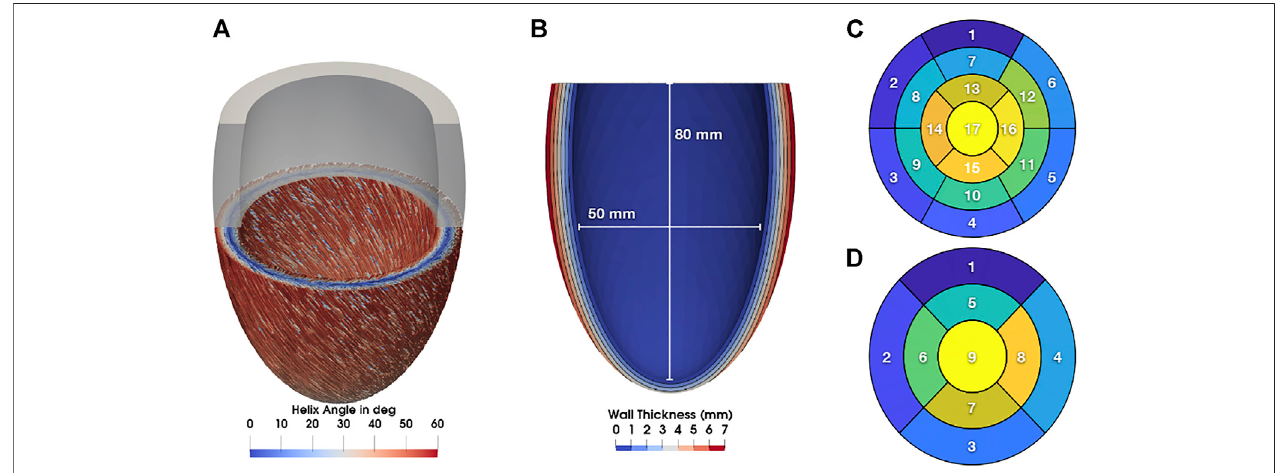
FIGURE 1 | (A) Myocyte orientation in the LV colorized with the corresponding helix angle. (B) Long axis cut through the LV with contours showing the wall thickness. Additionally, lengths for the calculation of the sphericity index are shown. (C) 17 AHA segments. (D) nine NOGA XP segments.